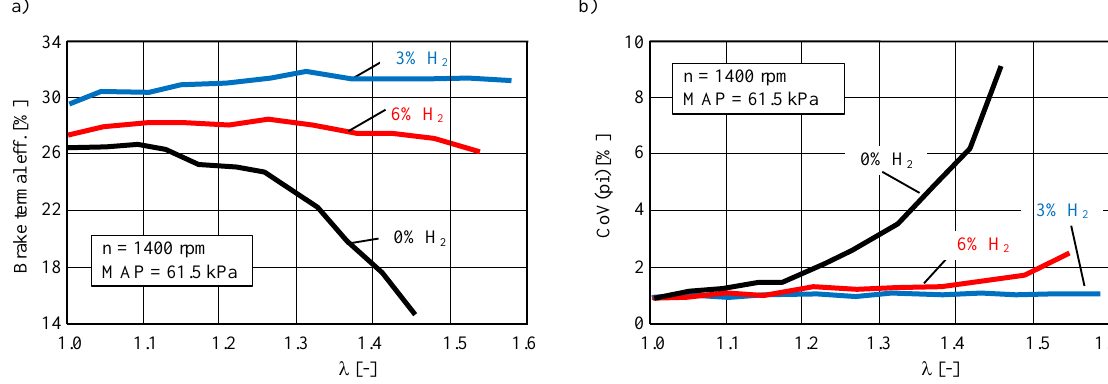
Fig. 4. Change of dual-fuel engine operating indicators: a) thermal efficiency, b) engine combustion instability coefficient [20]